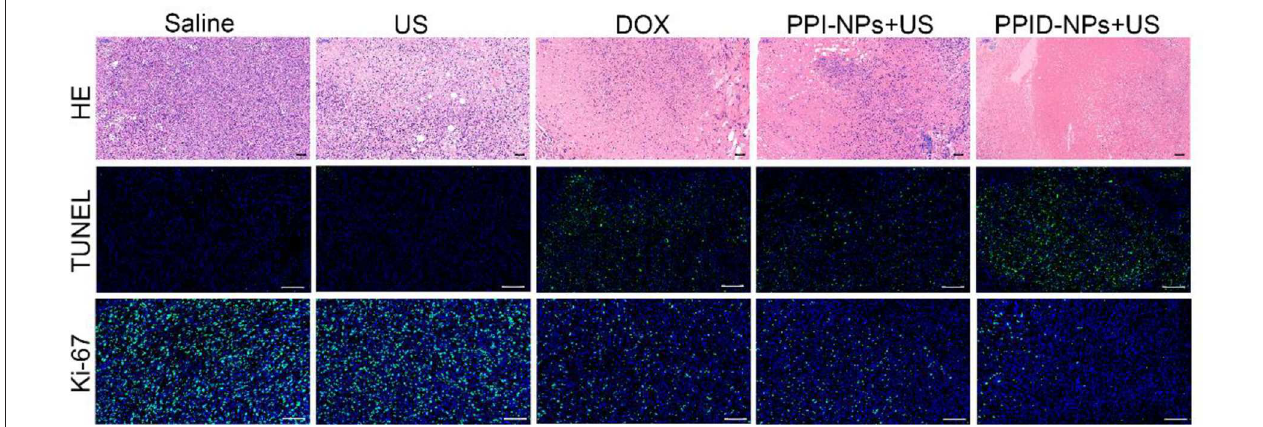
FIGURE 8 | H&E staining and TUNEL and Ki-67 assays of tumor tissue slices after various treatments (scale bar, 50 µ m).